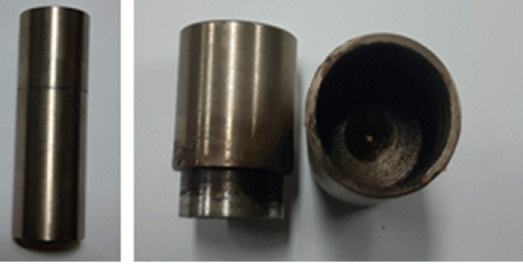
Figure 1. Prototype capsule.